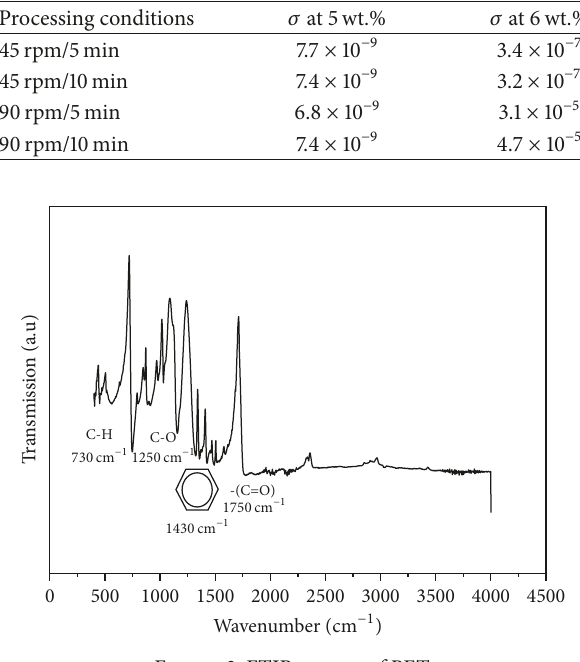
Figure 3: FTIR spectra of